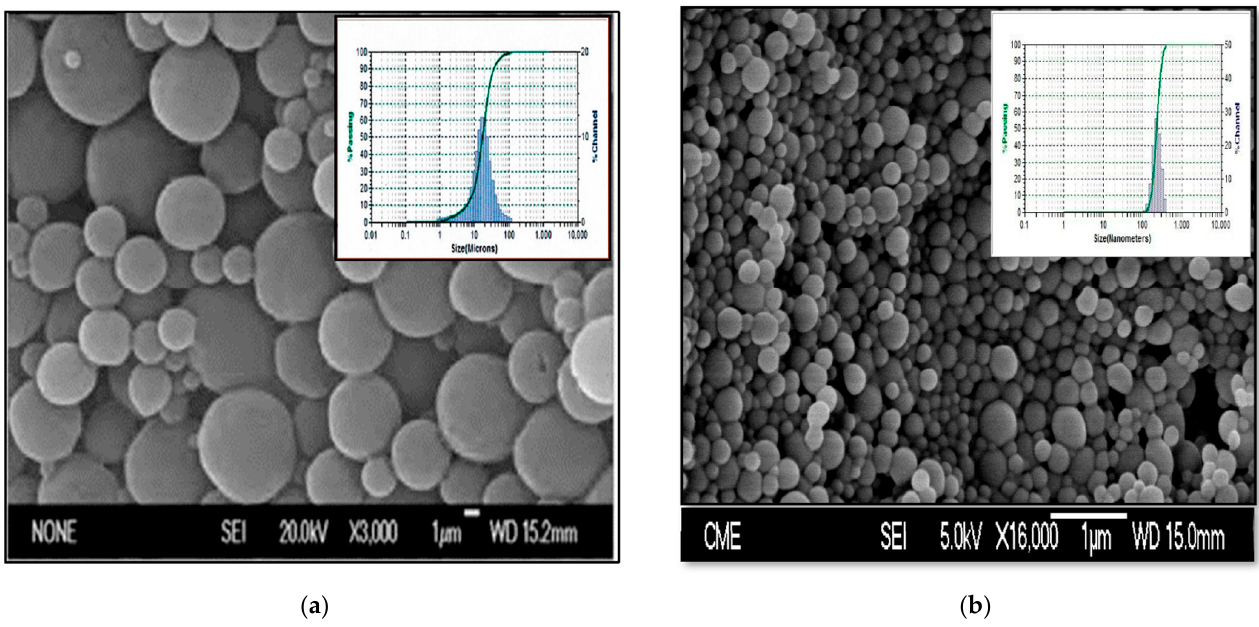
Figure 1. SEM microphotograph of TC-loaded PLGA MPs (formulation MP-TC4) and particle size distribution ( a ). SEM microphotograph of TC-loaded PLGA NPs (formulation NP-TC3) and particle size distribution ( b ). TC (tolcapone).